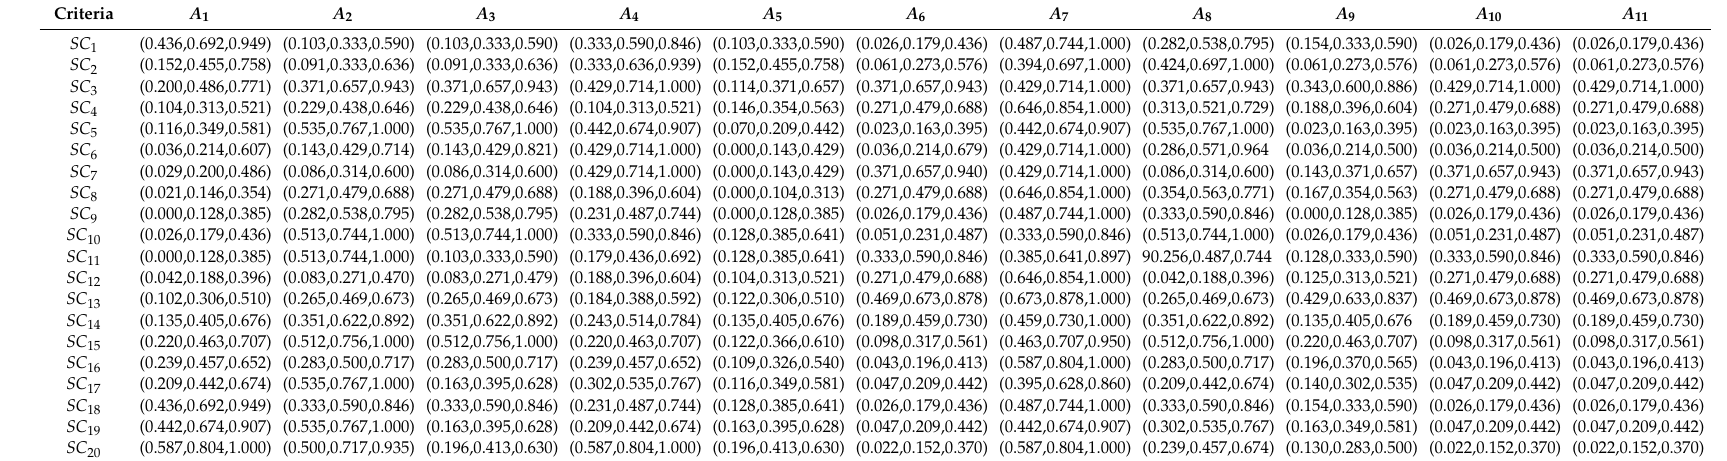
Table 4. The fuzzy normalized decision matrix of sustainable siliceous materials